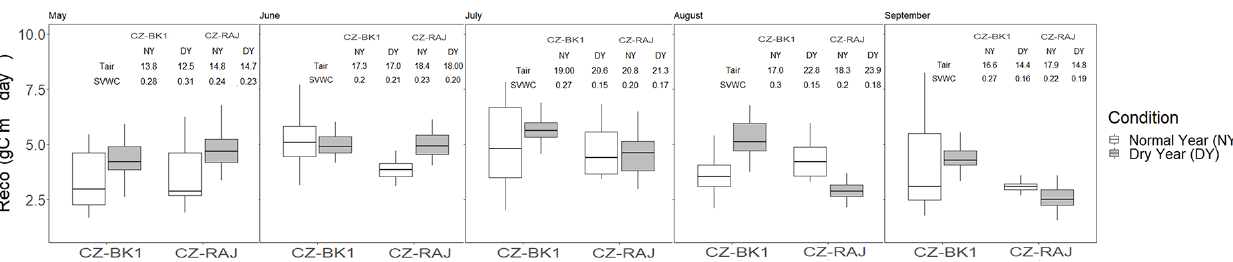
Figure 6. Monthly averages of daily sums of ecosystem respiration (R eco ) for May–September of the normal years (NY) and dry year (DY) in CZ-BK1 and CZ-RAJ. The tables within the figure represent the mean monthly air temperature (Tair) and soil volumetric water content (SVWC) values from May to September for each forest station.